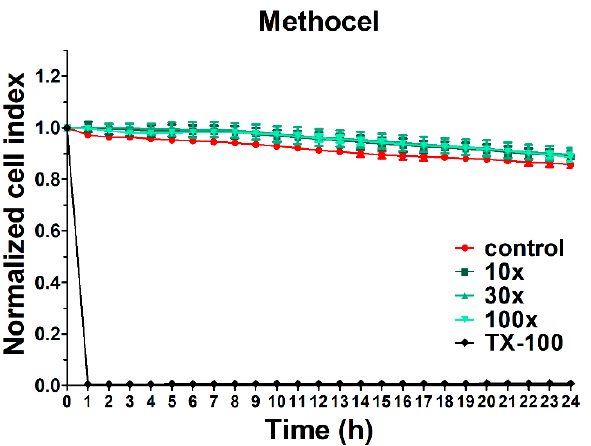
Figure 4. Cell viability of HCE-T cornea epithelial cells treated with Methocel measured by real-time electric sensing. Values are presented as means ± SD, n = 6–10. 10 × : 10-times dilution; 30 × : 30-times dilution; 100 × : 100-times dilution; TX-100, Triton X-100.